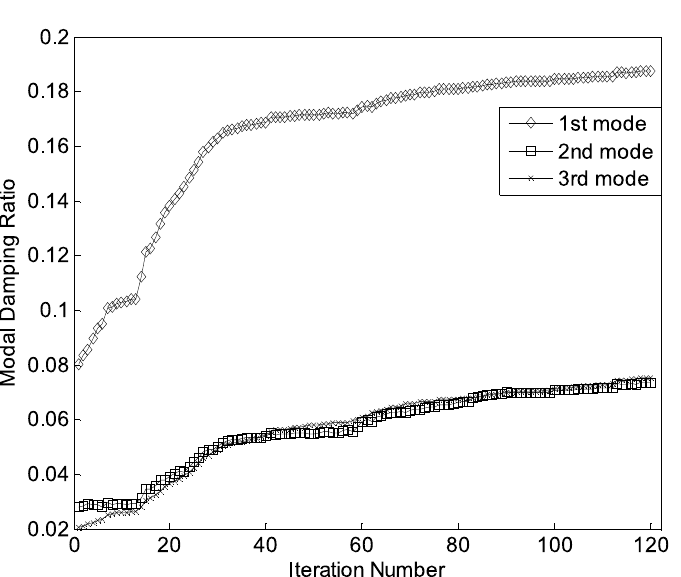
Fig. 7. Iteration histories for different modes vf = 0.2.